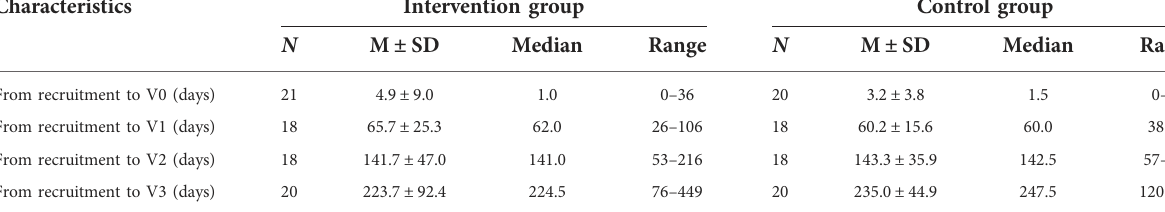
TABLE 3 Intervals between study recruitment and follow-up visits by